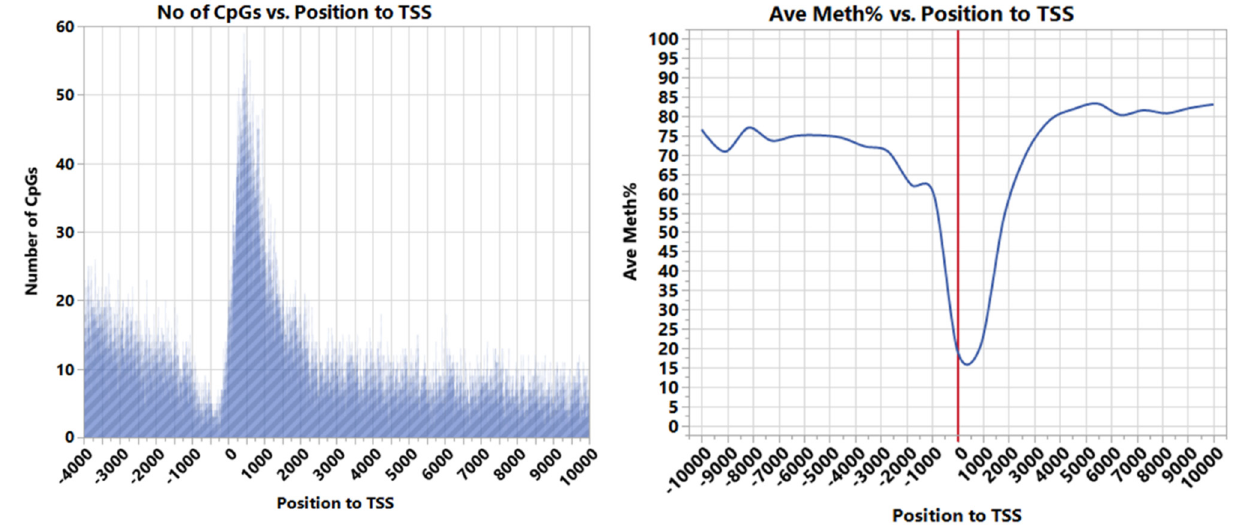
Figure 5. Number of CpGs located in CGI per nucleotide (left) and their average methylation percentage relative to gene TSS (right).